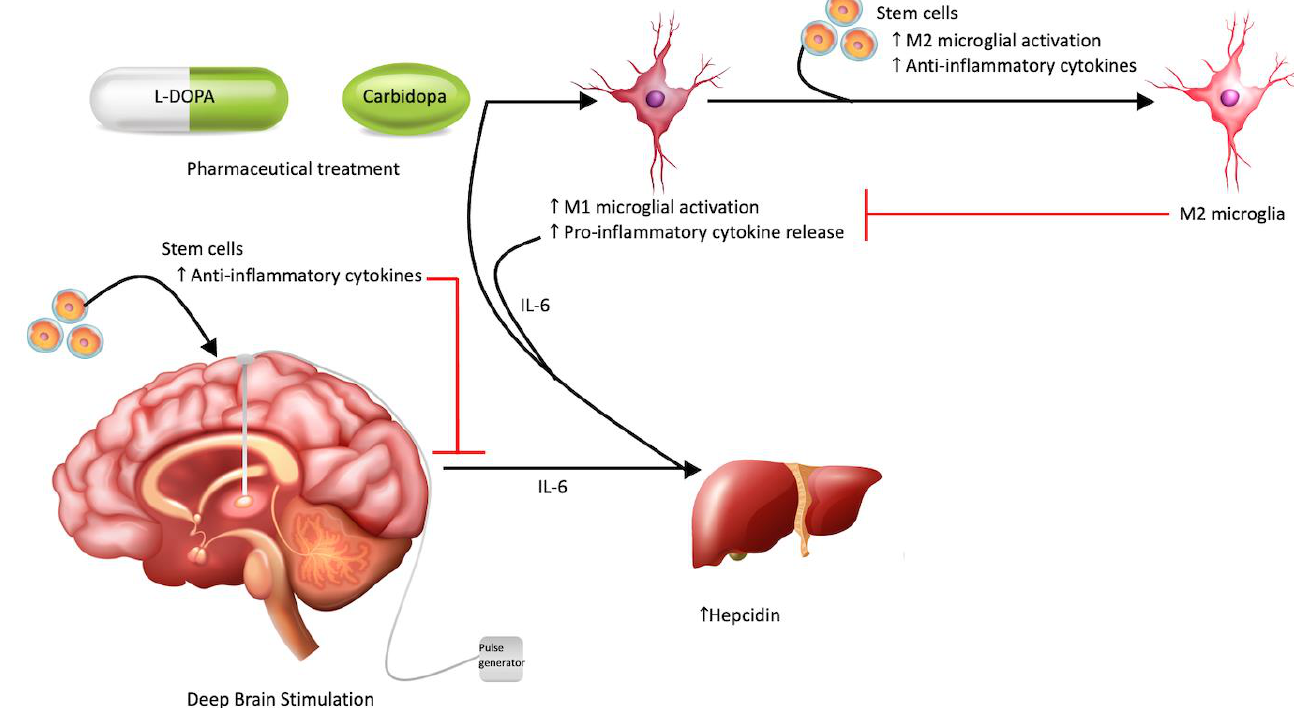
Figure 1. Therapeutic approaches to Parkinson’s disease. Typical treatment modalities for Parkin- son’s disease, such as DBS and pharmaceuticals (L-DOPA and Carbidopa), may amplify the pro- inflammatory environment of PD by preferentially stimulating M1 microglial differentiation and inflammatory cytokine release. These cytokines can also increase hepcidin, an acute phase protein, from the liver. Stem cells may act via the bystander effect to minimize this neuroinflammation by shifting microglial differentiation to M2 and increasing anti-inflammatory cytokines.